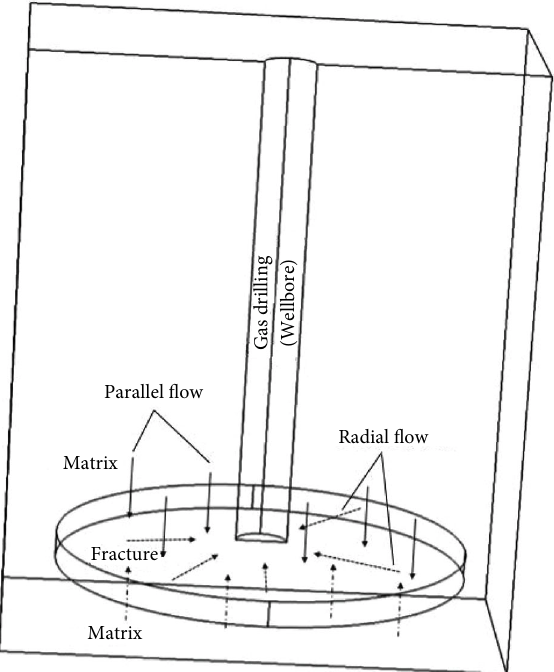
Figure 1: Physical model of gas fl ow process in matrix-fracture reservoirs opened by gas